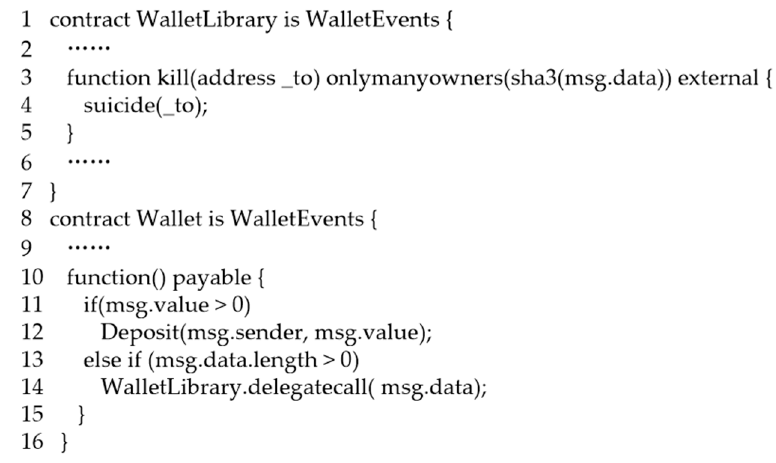
Figure 5. A typical example of delegatecall vulnerability.